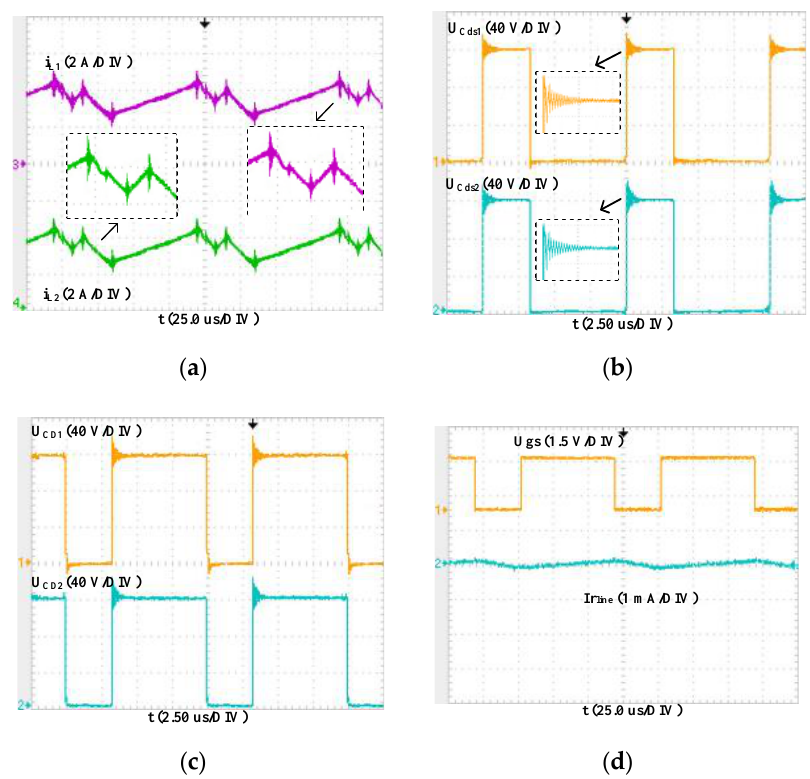
Figure 15. Experimental waveforms considering parasitic parameters for Po = 200 W. ( a ) Experimental waveform of inductor current. ( b ) Experimental waveform of MOSFET voltage. ( c ) Experimental waveform of diode voltage. ( d ) Experimental waveform of centerline current.